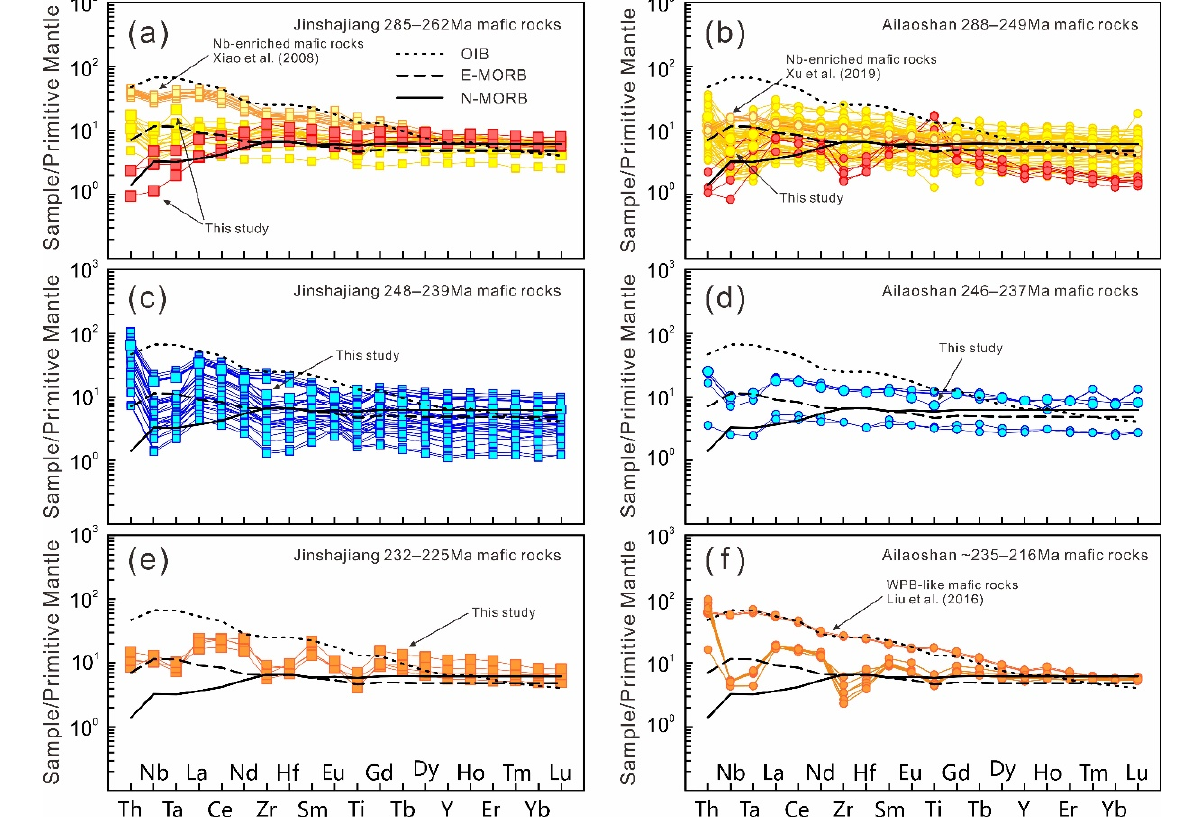
Figure 9. Primitive mantle-normalized incompatible element spidergrams for the Devonian-Triassic mafic rocks in the Jinshajiang and Ailaoshan orogenic belts. (a) 285–262 Ma mafic rocks in the Jinshajiang orogenic belt; ( b ) 288–249 Ma mafic rocks in the Ailaoshan orogenic belt; ( c ) 248–239 Ma mafic rocks in the Jinshajiang orogenic belt; ( d ) 246–237 Ma mafic rocks in the Ailaoshan orogenic belt; ( e ) 232–225 Ma mafic rocks in the Jinshajiang orogenic belt; ( f ) 235–216 Ma mafic rocks in the Ailaoshan orogenic belt; Detailed data sources are listed in Supplementary Table S10. The legends are the same as those in Figures 5 and 10.